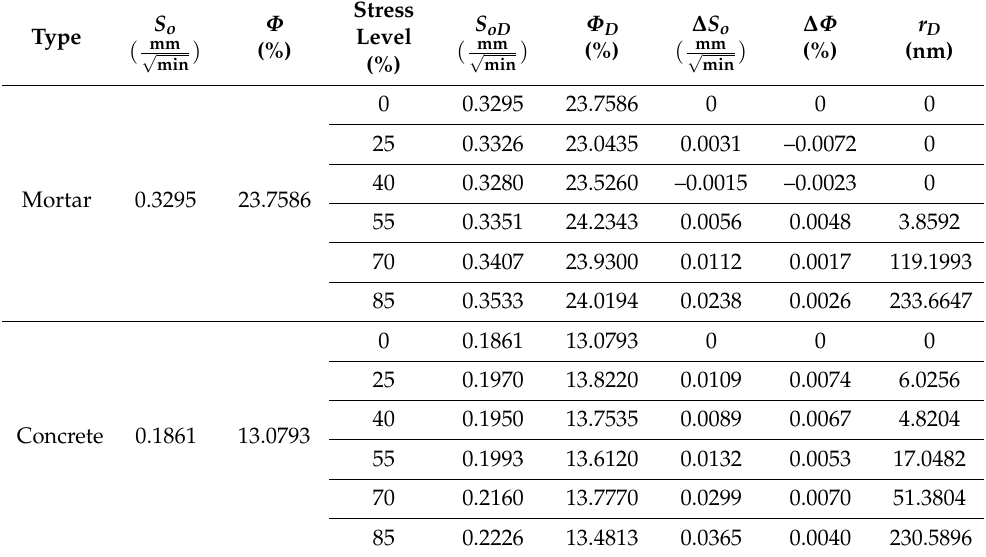
Table 6. Damage-representative radii of damaged mortar and concrete (w/c =